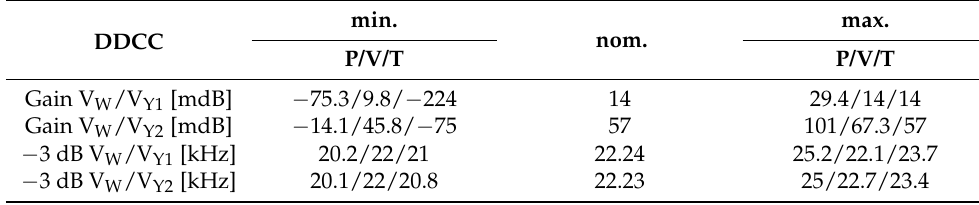
Table 3. The PVT corner analysis results for the DDCC. Figure 9. The DC output current ( a ) and transconductance g m ( b ) characteristics of the TA versus input voltage.